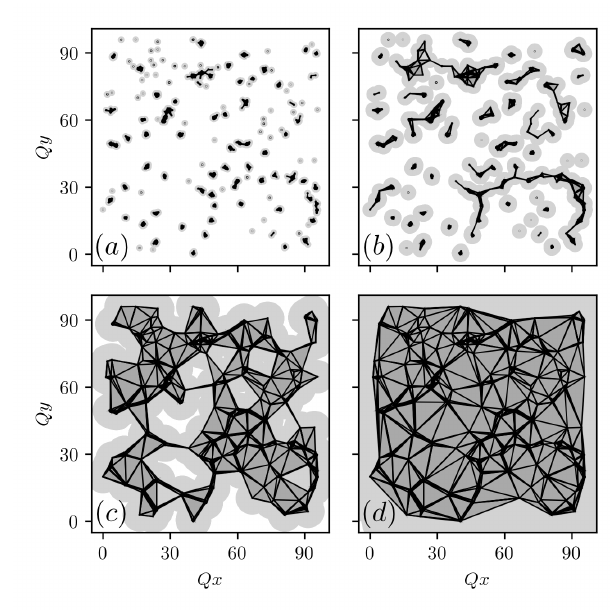
Figure 4: Alpha complexes of various radii Qr of the point cloud X ν ( Qt = 3750 ) for ¯ ν = 0.6 as displayed in Fig. 3. Panel (a): Qr = 1.0. Panel (b): Qr = 3.0. Panel (c): Qr = 7.0. Panel (d): Qr =